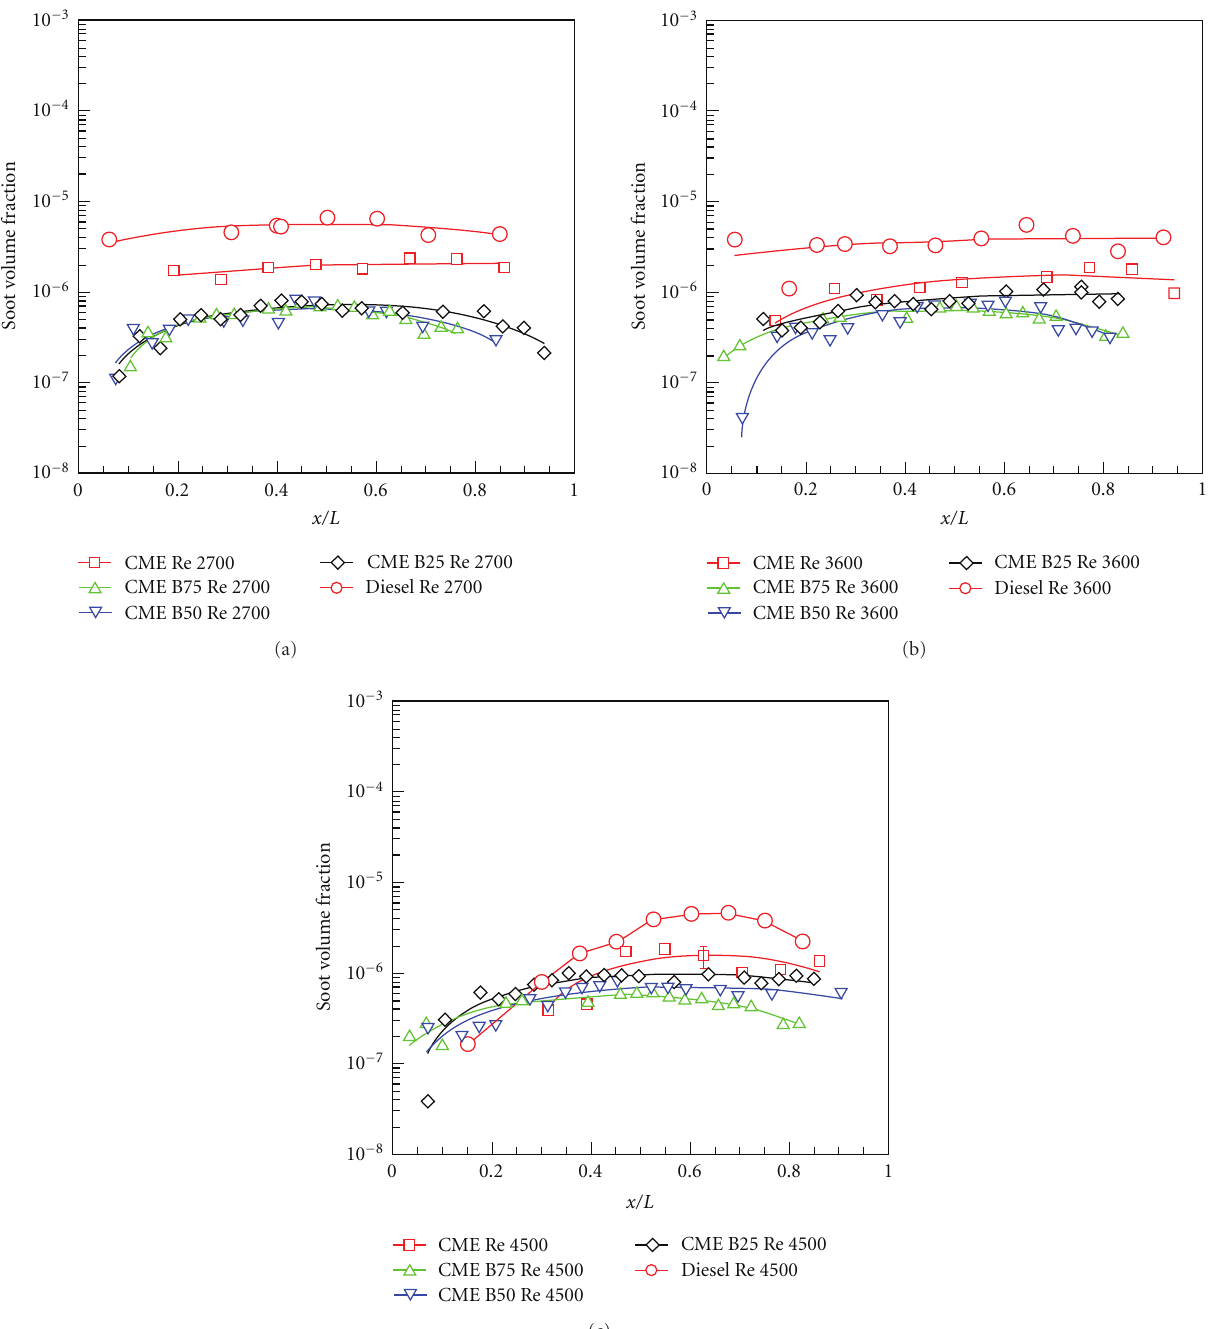
Figure 11: Axial profiles of soot volume